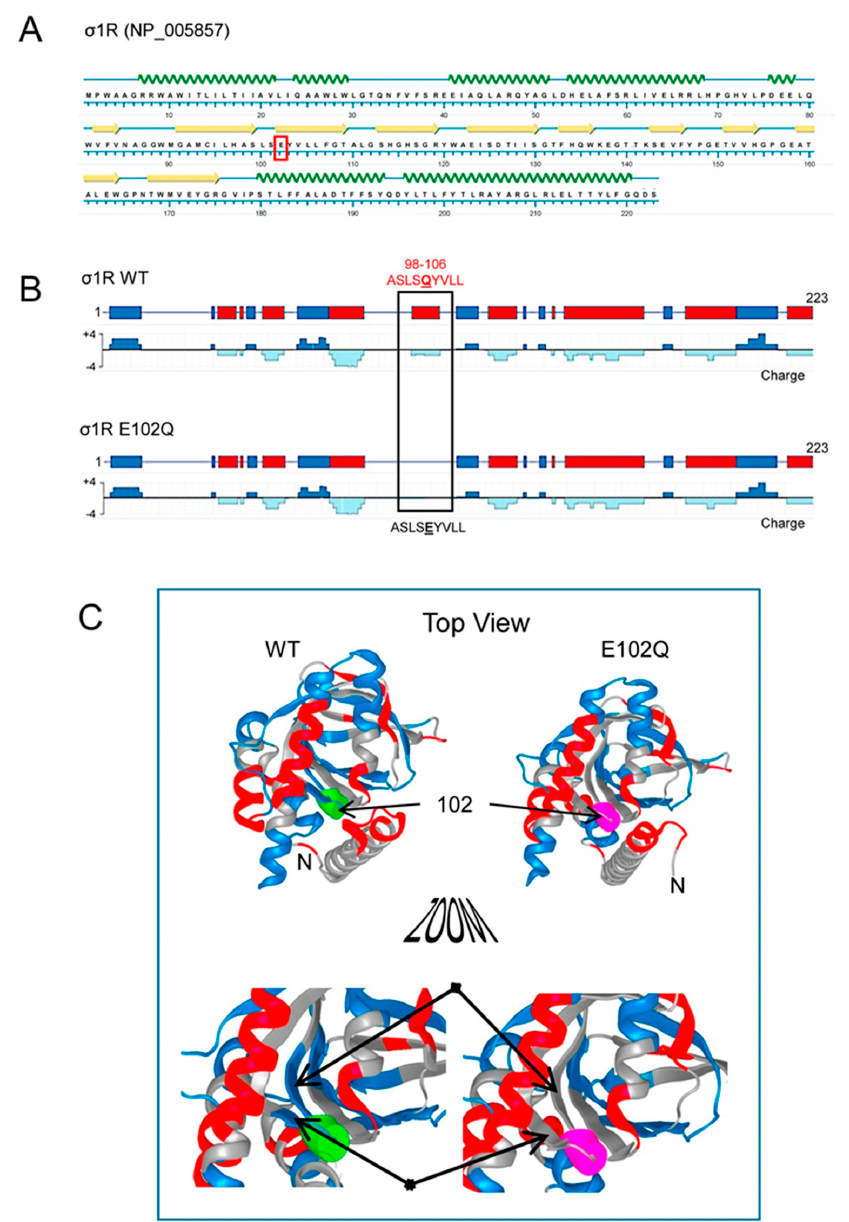
Figure 1. Secondary structure, charge distribution map, and 3D model of sigma receptor type 1 ( σ 1R). ( A ) Protein sequence and secondary structure of σ 1R, with helices indicated by green waves and β -sheets by yellow arrows. The amino acid change in human σ 1R associated with the juvenile form of amyotrophic lateral sclerosis (ALS) is indicated in red. ( B ) Charge distribution map of wild-type (WT) σ 1R and σ 1R E102Q (the images were created using NovaFold v17, DNASTAR, Inc., Madison, WI, USA). Positive charges are indicated by blue and negative charges are indicated by red. The E102Q mutant protein lacks a negatively charged cluster located in the linker region between β 2 and β 3 (residues 98–106, ASLSEYVLL). ( C ) 3D structure of σ 1R showing the WT and mutated amino acid as a colored tube. E102 is indicated by green and Q by pink. The structural model of σ 1R and its secondary structure shown here were generated with NovaFold v. 17